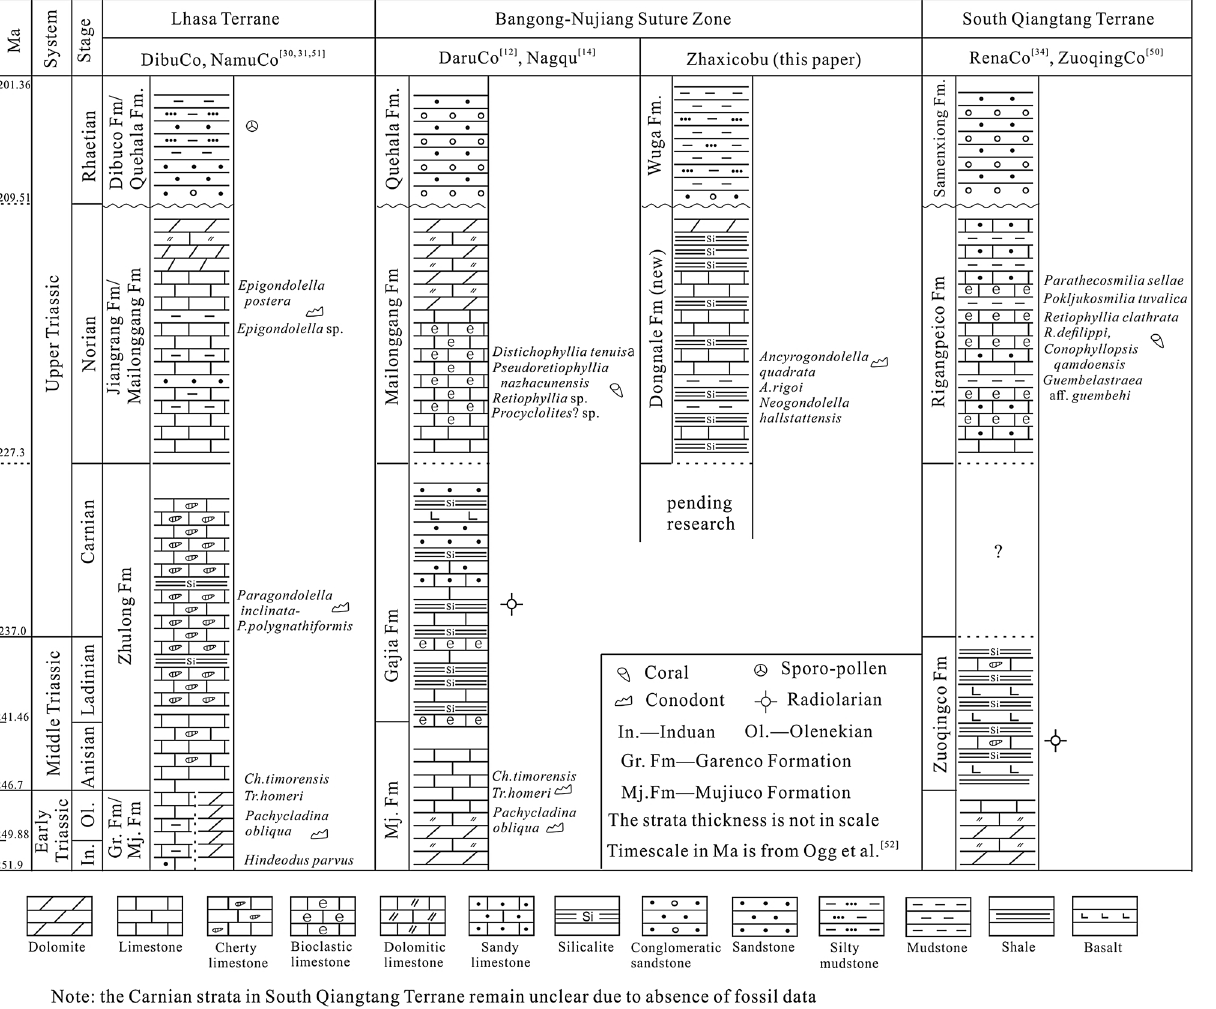
Figure 5. Triassic sedimentary successions described from the BNSZ, Lhasa Terrane, and South Qiangtang Terrane. The main fossil taxa are marked beside each